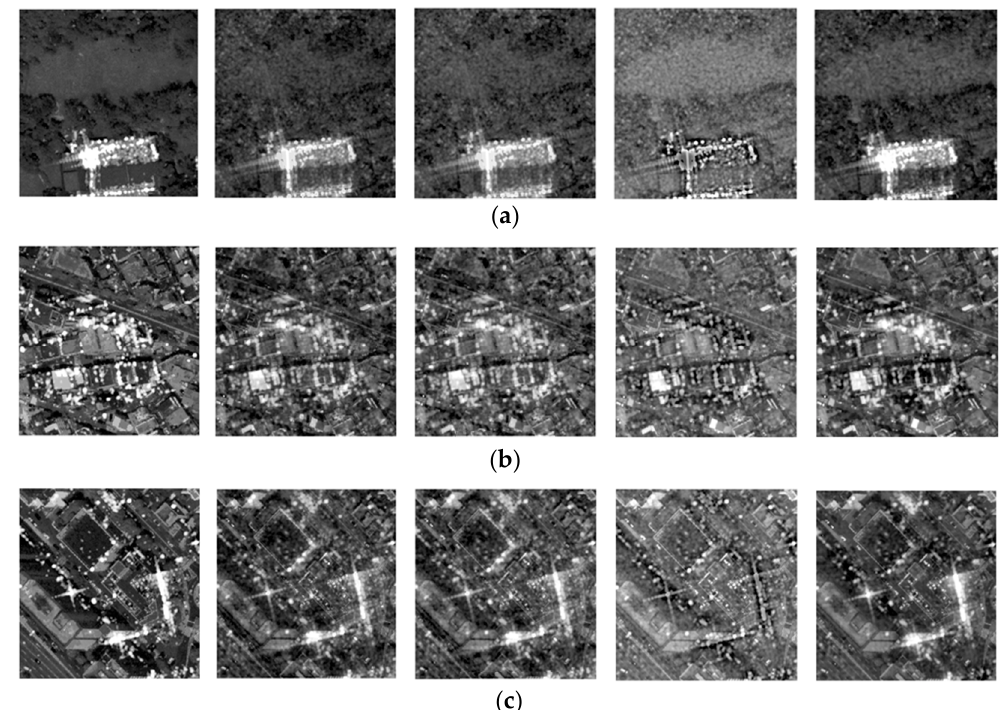
Figure 9. Enlargement of the area marked with a red rectangle: ( a ) Site 1, ( b ) Site 2, ( c ) Site 3. From left to right: proposed method, a-trous wavelet decomposition, discrete wavelet transforms, non-subsampled contourlet transform, and non-subsampled contourlet transform-pulse couple neural network.